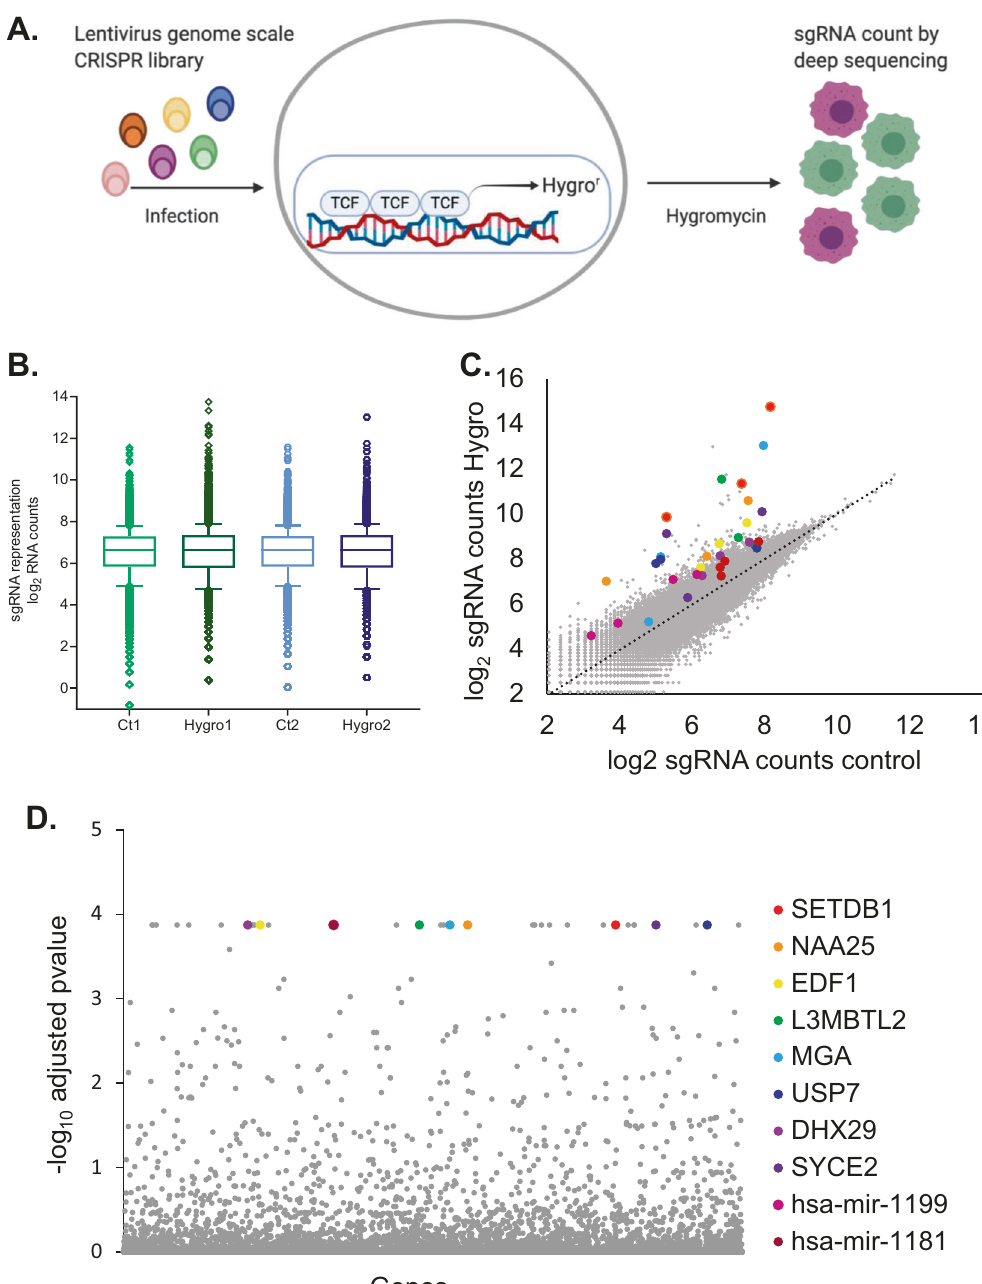
Fig. 1 Wnt repressors CRISPR screen. A Schematic representation of the canonical Wnt signaling reporter plasmid and the screening strategy. B Tukey boxplot showing the distribution of sgRNA frequencies before and after hygromycin selection in the two biological repeats. Boxes; 25 – 75th percentile, whiskers; 1.5 times the interquartile range. C Scatter plot showing enrichment of sgRNAs targeting the top candidate genes (colored dots) compared to other sgRNAs in the library (gray dots) following hygromycin selection in the fi rst screen repeat. D Scatter plot showing the signi fi cance (FDR adjusted p -value) of each gene in the two screen repeats. The top ten ranking genes are color previously used as a screening tool [13] (Fig. 1A). The reporter was RESULTS stably transfected into HEK293 cells, in which the β -catenin Establishment of a GeCKO screening system based on destruction complex is active and the level of Wnt signaling Wnt-induced cell survival under antibiotic selection activity is therefore minimal. We speculated that cells in which a The aim of the study was to use a CRISPR library in order to Wnt inhibitor is silenced would become resistant to the identify novel regulators of the canonical Wnt signaling pathway. hygromycin B antibiotic since the hygromycin resistance gene is Knocking out potential pathway repressors leads to pathway regulated by the TCF-binding sites. Preliminary assays were activation and subsequent hygromycin resistance of the cells conducted to determine hygromycin concentration and screening mediated by a reporter plasmid TCF/HSV-TK, which we have